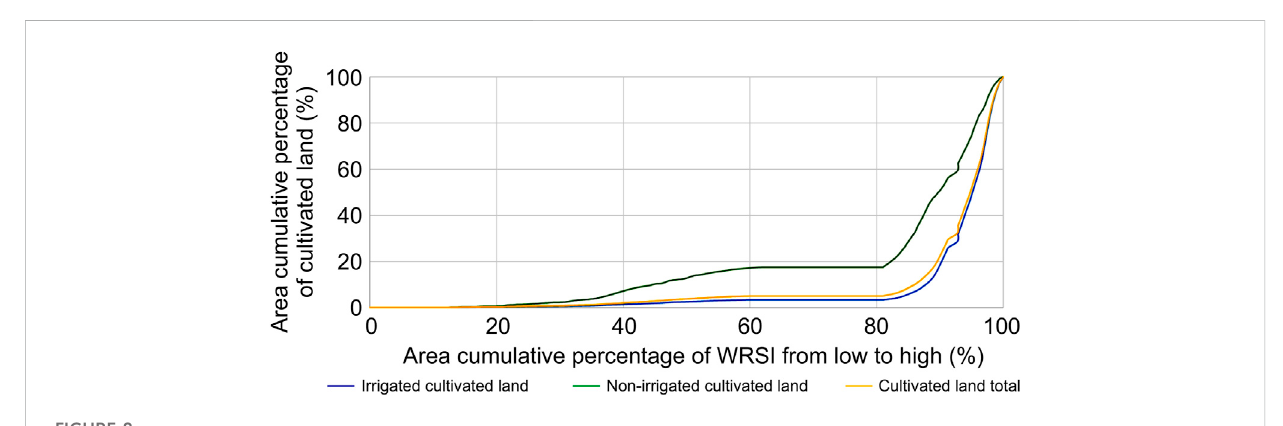
FIGURE 7 Wrsia in Lhasa city.